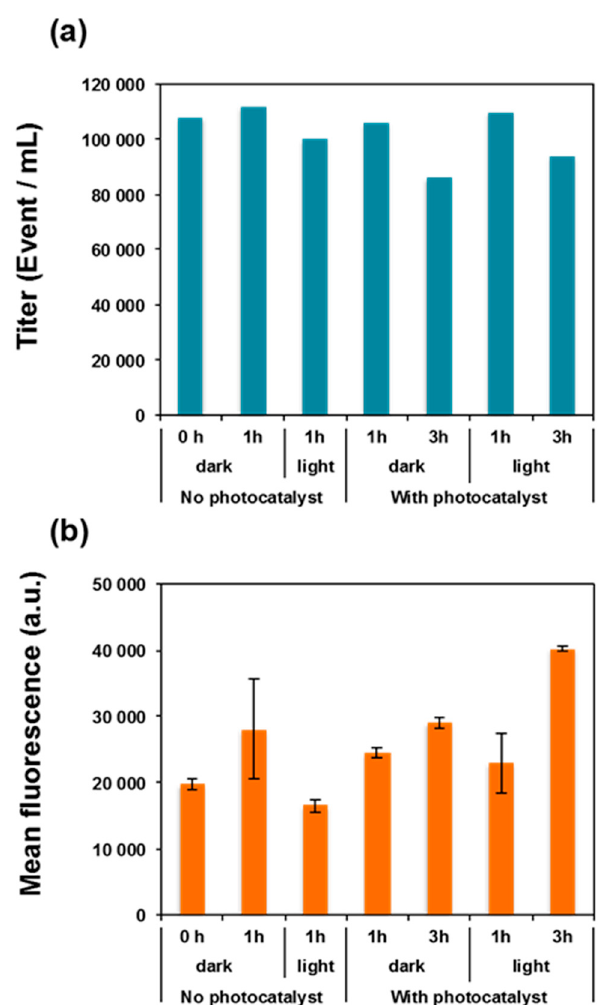
Figure 7. ( a ) Concentration of bacterial cells detected by flow cytometry (FCM) after SYBR Green II staining and ( b ) mean fluorescence intensity of the SYBR Green II fluorochromes per cells. Error bars represent Standard Error of the mean. Each data point represents 1900–3800 events acquired by FCM.